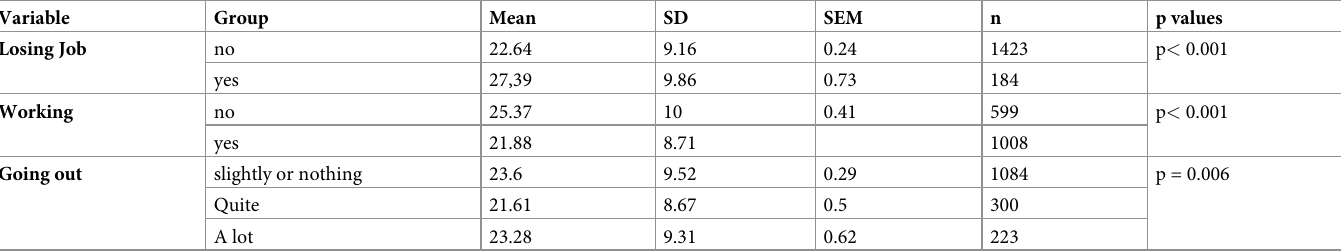
Table 3. Variables that were significant as regards perceived